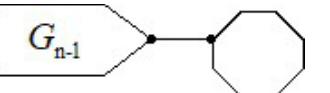
Figure 1. A cyclooctylene chain G n with n